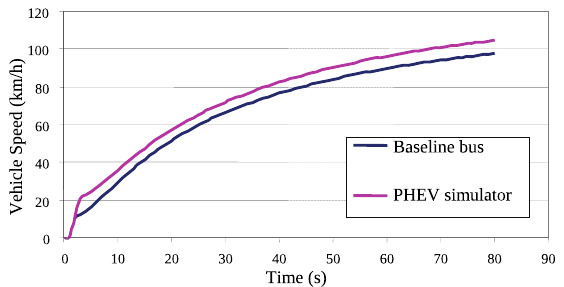
Figure 4. Comparison of the vehicle speed.